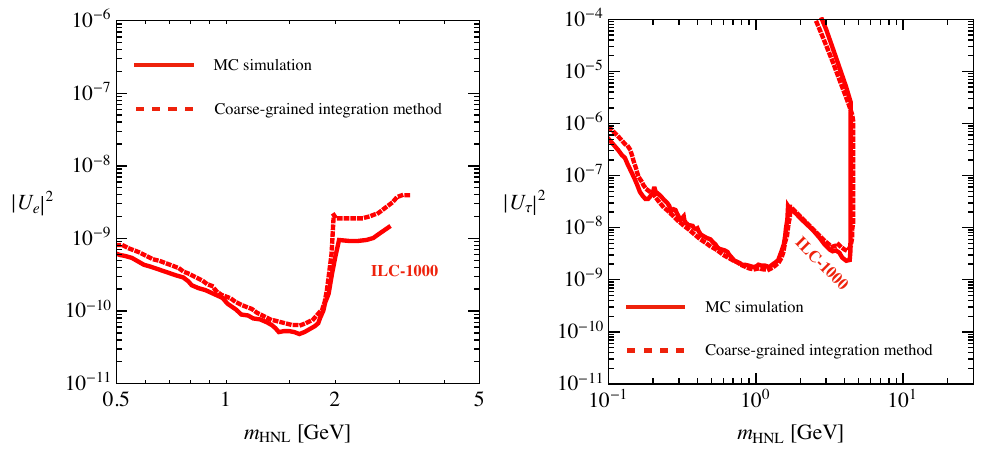
Figure 10 . The left (right) panel shows the curves corresponding to three signal events with 10 - year statistics for the U ( U ) dominant scenario at ILC-1000. For simplicity, we assume the signal e τ events are the HNL decays inside the decay volume except for HNL → νν ¯ ν . The solid (dashed) lines correspond to the limit based on the Monte-Carlo simulation (the coarse-grained integration method). Note that the curves of the coarse-grained integration method almost reproduce that of the Monte-Carlo simulation.